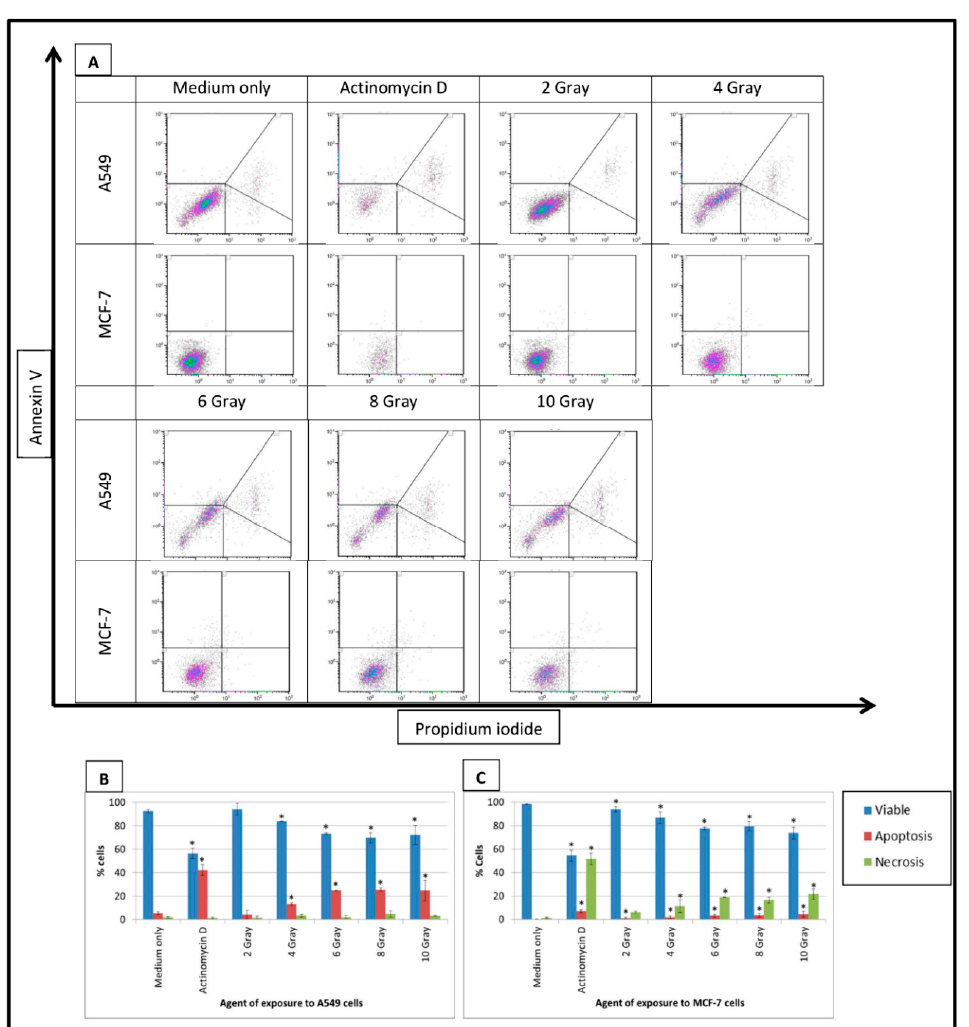
Figure A2. Annexin V-FITC flow cytometric density dot plots of A549- and MCF-7 cells exposed to a radiation dose range. Annexin V-FITC (FL1) measured apoptotic cells and was plotted against propidium iodide (FL3) that measured necrotic cells ( A ). Cells propagated in medium only